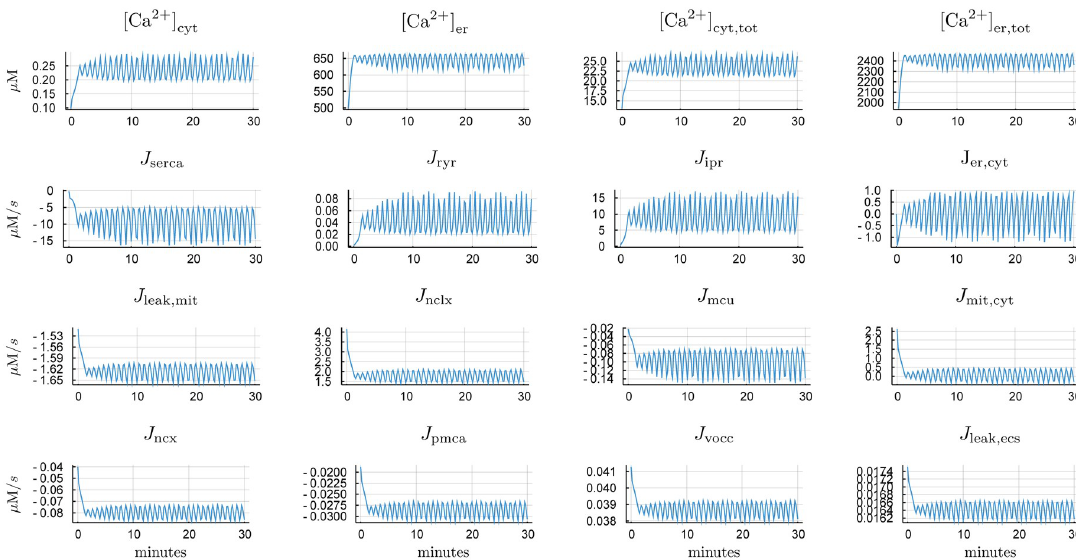
Fig 3. Model time courses for [Ca 2+ ] mit = 0.25 μ M. Positive fluxes correspond to flow into the cytosol. We distinguish between free and total calcium in each of the ER and cytosol. Mitochondrial calcium assumed to be in quasi-steady equilibrium with respect to dissolution and